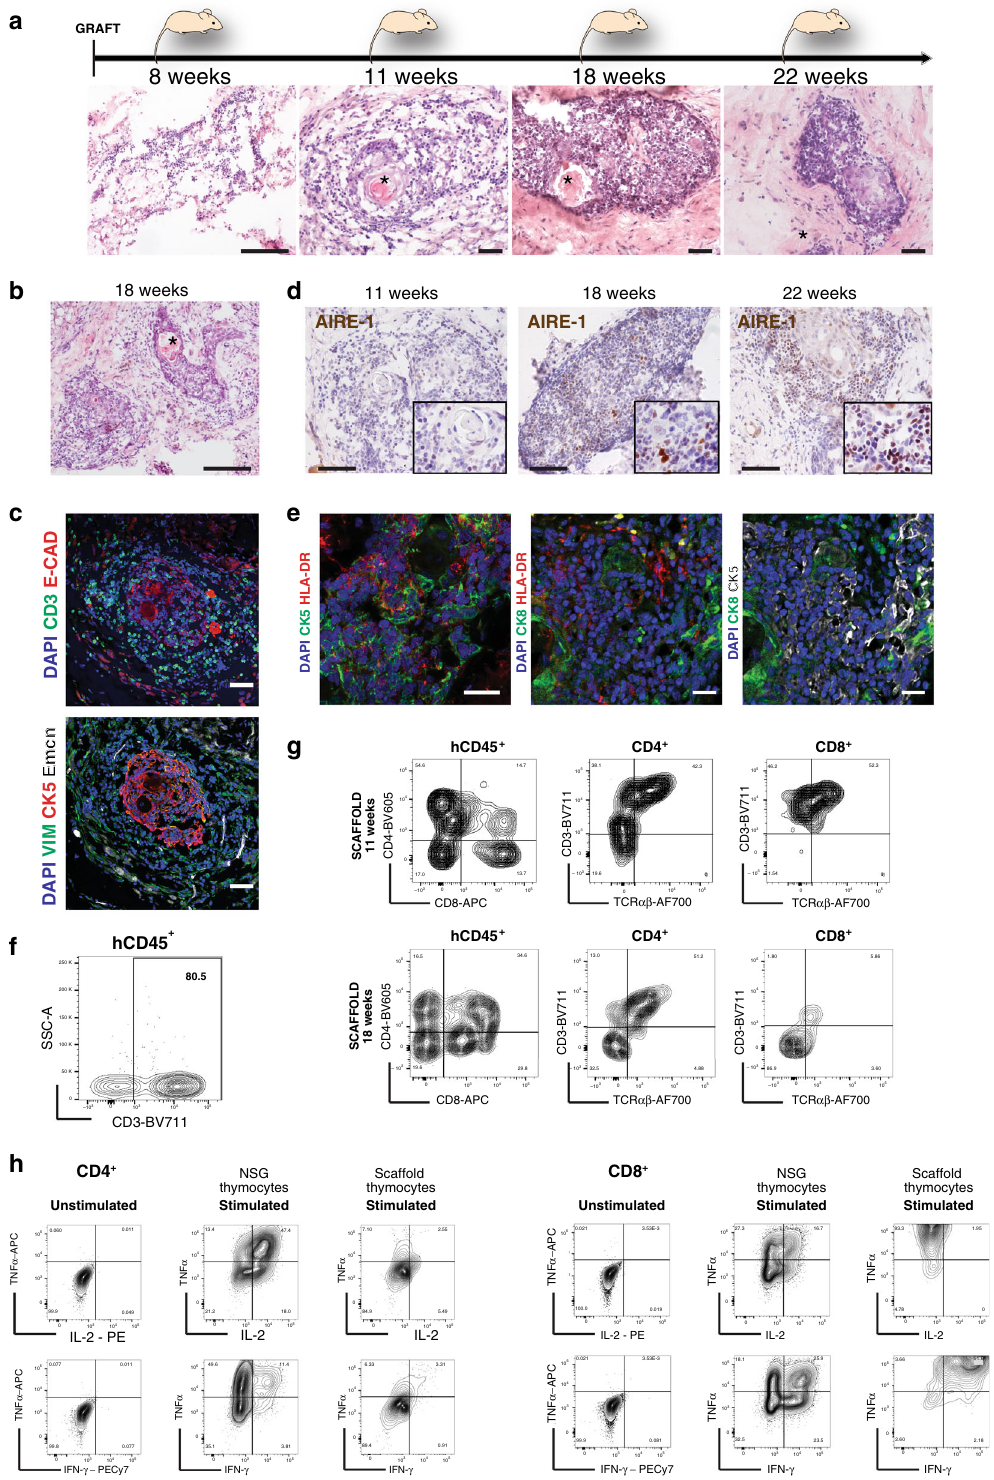
DNase I (Roche) in RPMI, 2% FBS and 1% Penicillin/Streptomycin). Cells were pelleted and processed for ammonium chloride red cell lysis. FL MNCs were magnetically sorted for CD34 positivity. Thymocyte isolation and sorting . Human thymocytes were obtained by mechanical tissue dissociation of postnatal thymi. Enrichment of triple